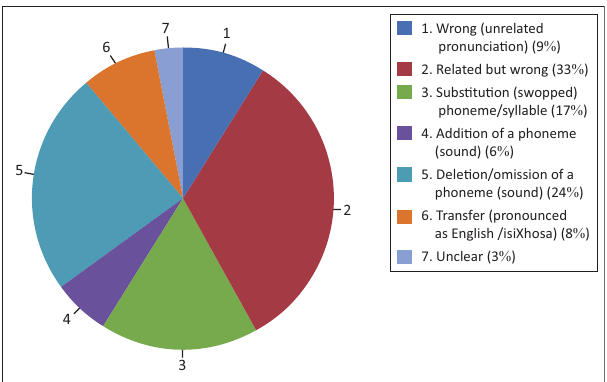
FIGURE 5: School X English real words ( n = 64). Combination of Lexical and sublexical strategies.